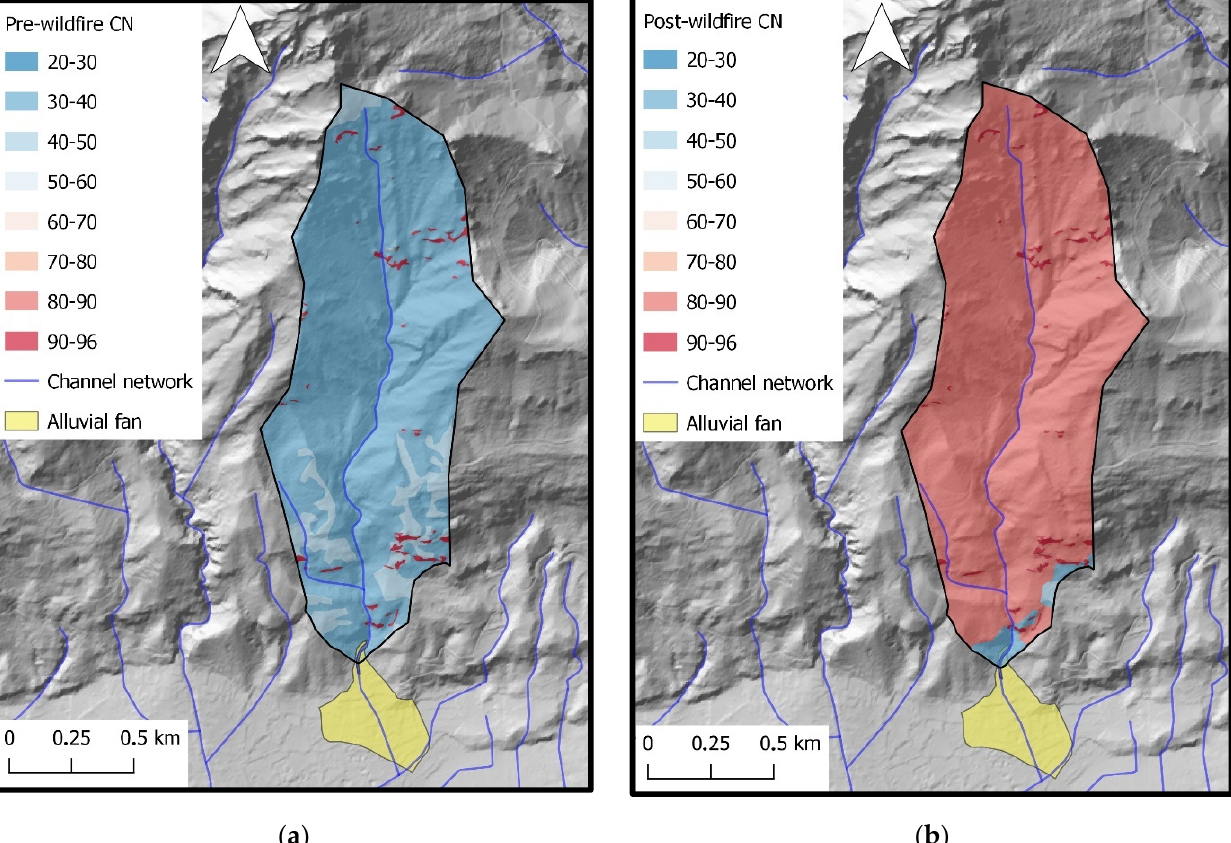
Figure 13. ( a ) Calculated CN for the Rio delle Foglie catchment before the wildfire; ( b ) calculated CN for the Rio Casella catchment after the wildfire.